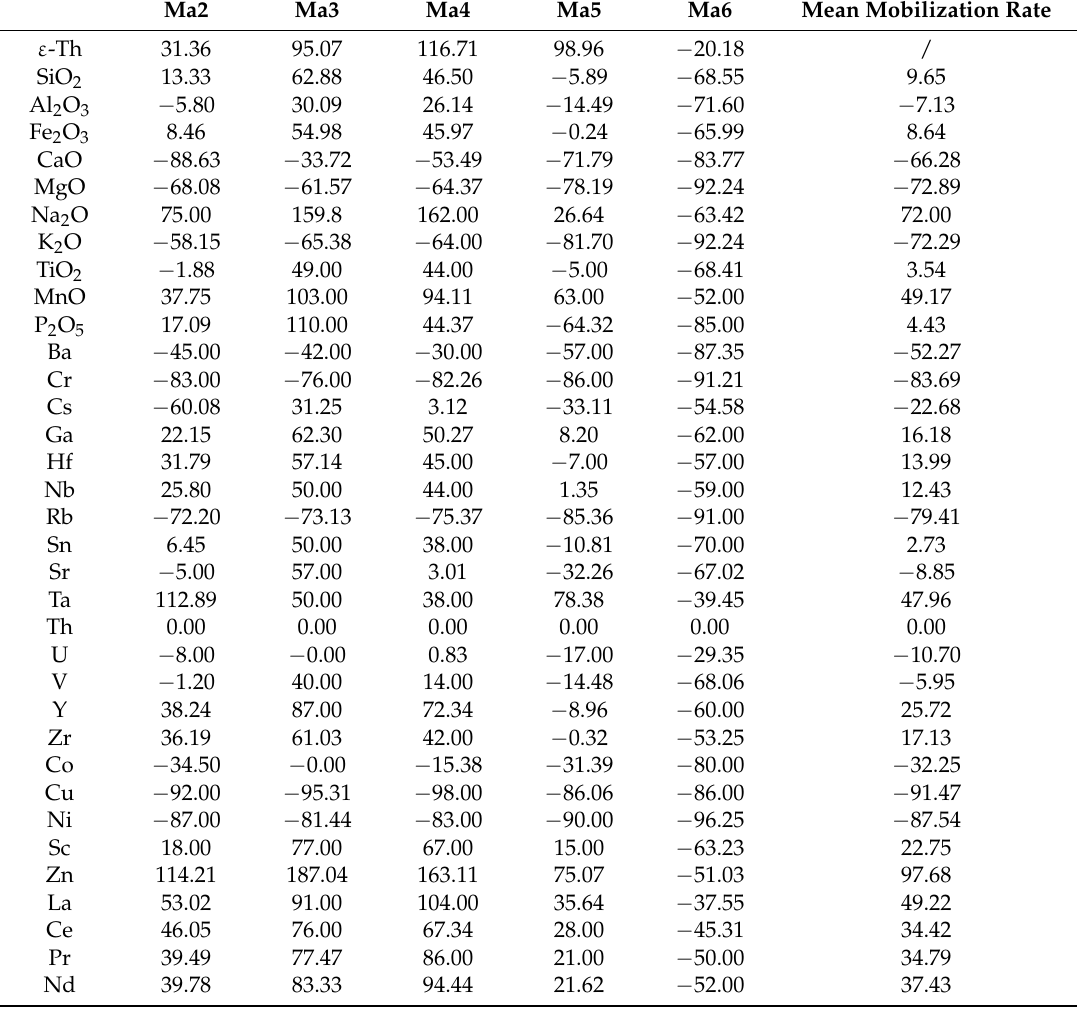
Table 2. Mass balance evaluation of major elements, trace elements and REE (%) for the soil profile samples in the Maroua region